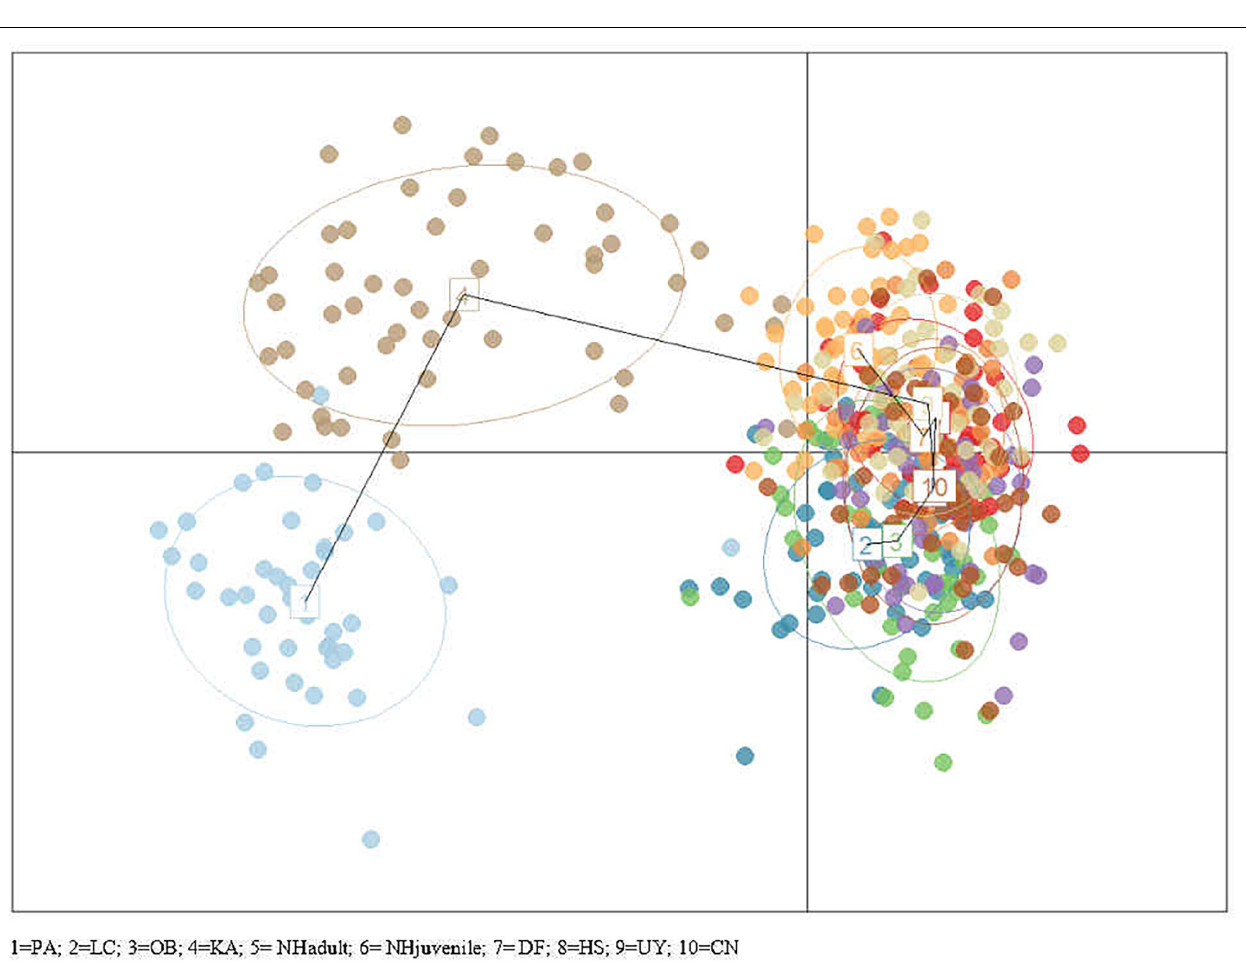
collective protection could be made (Martens et al.,